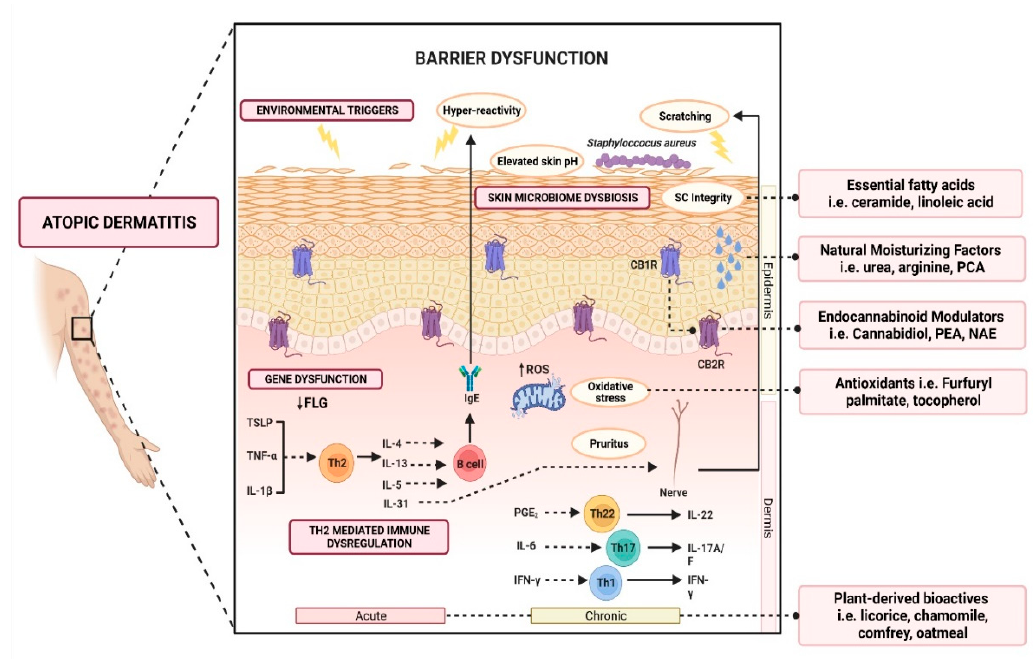
Figure 1. Schematic illustration of various active ingredients and the targeted mechanisms in alleviating atopic dermatitis.